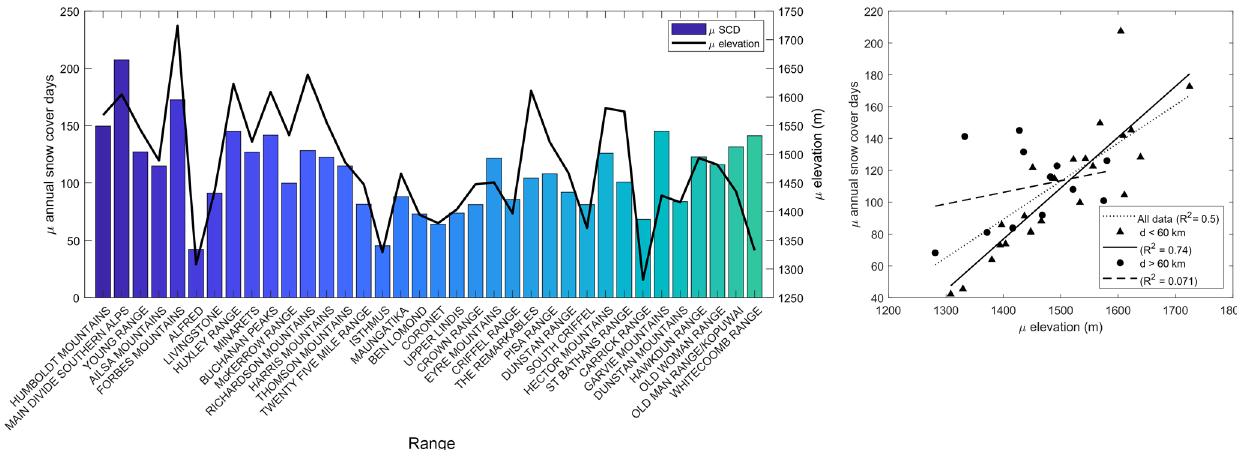
Figure 13. Relationship between mean annual SCD and mean elevation of each mountain range. Ranges are sorted from left to right by their proximity to the Main Divide of the Southern Alps. The relationship between elevation and snow cover persistence was found to be much stronger in the western (within 60km of the Main Divide) part of the catchment than in the east. Table 4. Parameters of regression between basin snow cover metrics and winter SOI and SAM values. SOI SAM Metric bSCA (%) sign